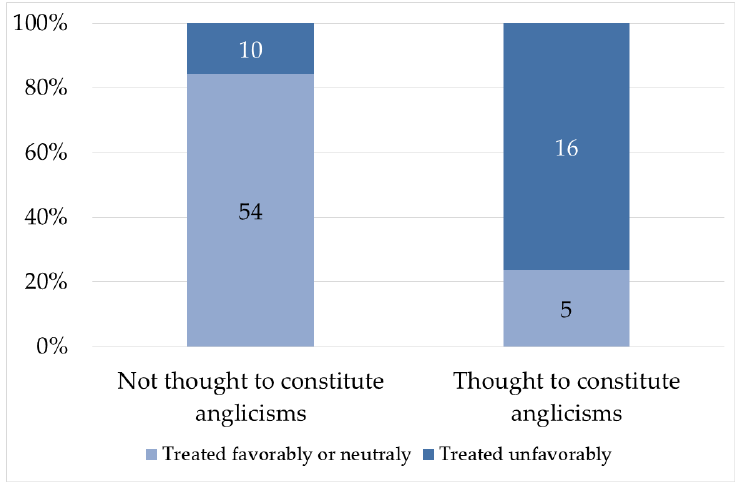
Figure 2 . Classroom treatment reported by instructors as a function of purported relation to English.